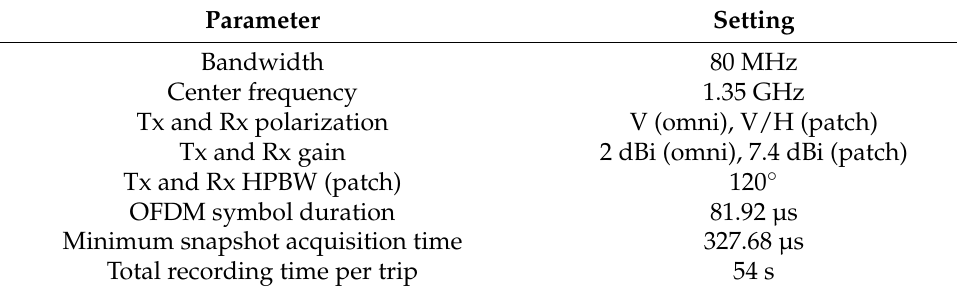
Table 1. MIMOSA Channel Sounder